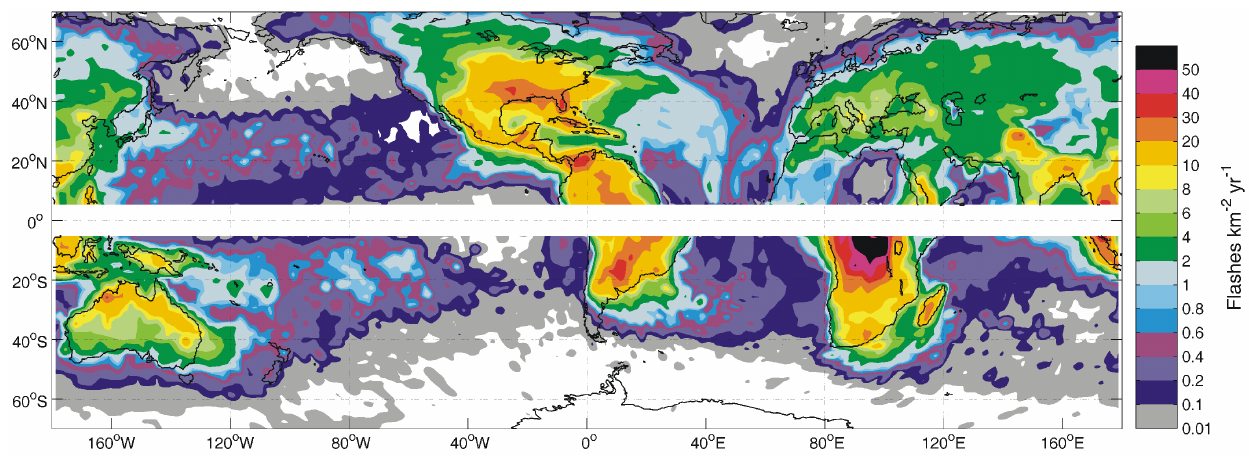
Fig. 1. The annual average global total lightning activity (in units of flashes km − 2 yr − 1 ) transformed into CGM geomagnetic co-ordinates.